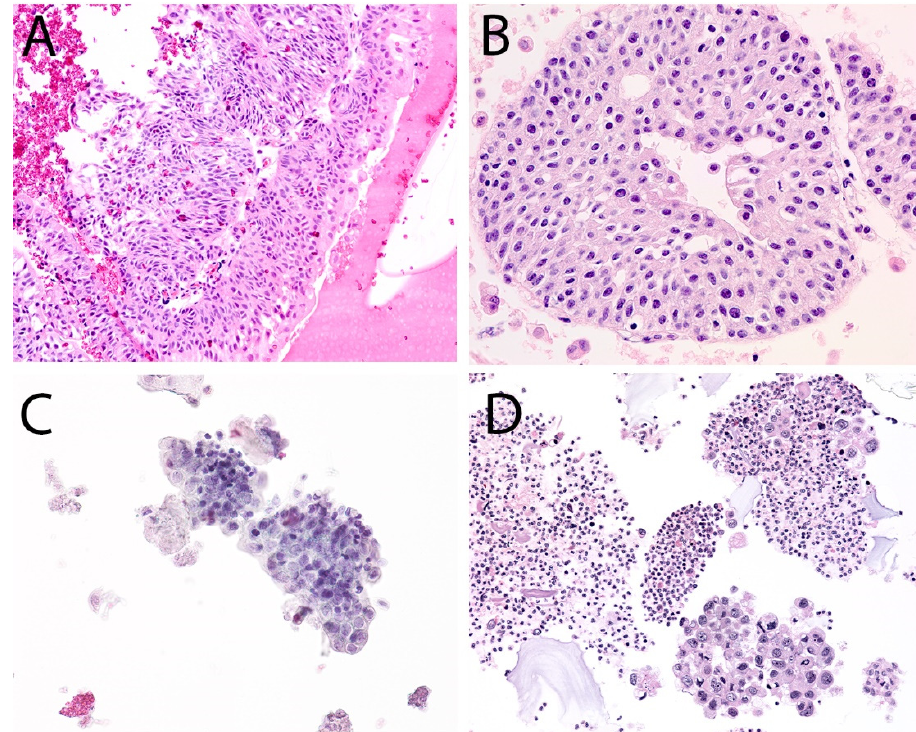
Figure 7. Examples of low-grade urothelial carcinoma ( A , B ) and high-grade urothelial carcinoma ( C , D ) in cell block preparations. Cell block preparations may allow for a better assessment of atypical cytologic features in tissue fragments that are otherwise obscured in cytologic preparations. Here, the high-grade urothelial carcinoma nuclei ( C , D ) are enlarged and more pleomorphic, whereas the low-grade urothelial carcinoma nuclei ( A , B ) are monotonous, and the cells have lower nuclear-to-cytoplasmic ratios.